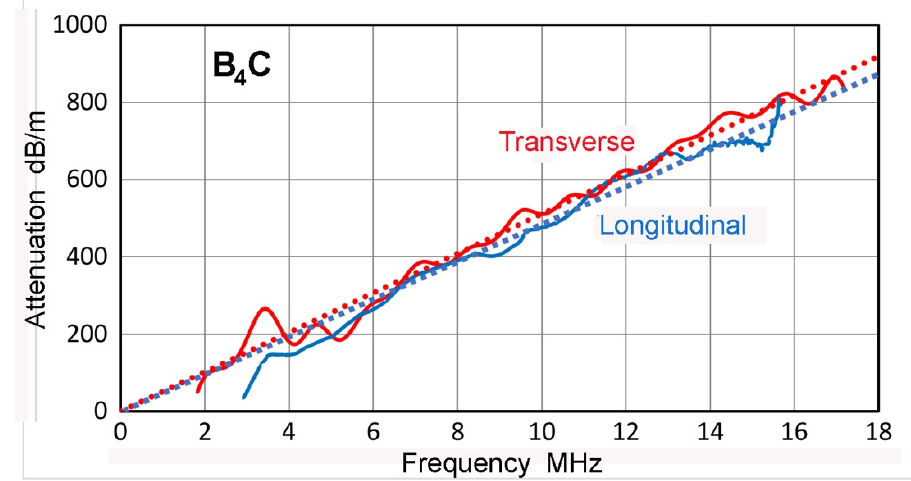
Figure 8. Attenuation (dB/m) vs. frequency, f (MHz) for B 4 C. Blue solid and dotted curves are for the observed and linearly fitted longitudinal attenuation and red solid and dotted curves are for the corresponding transverse attenuation.